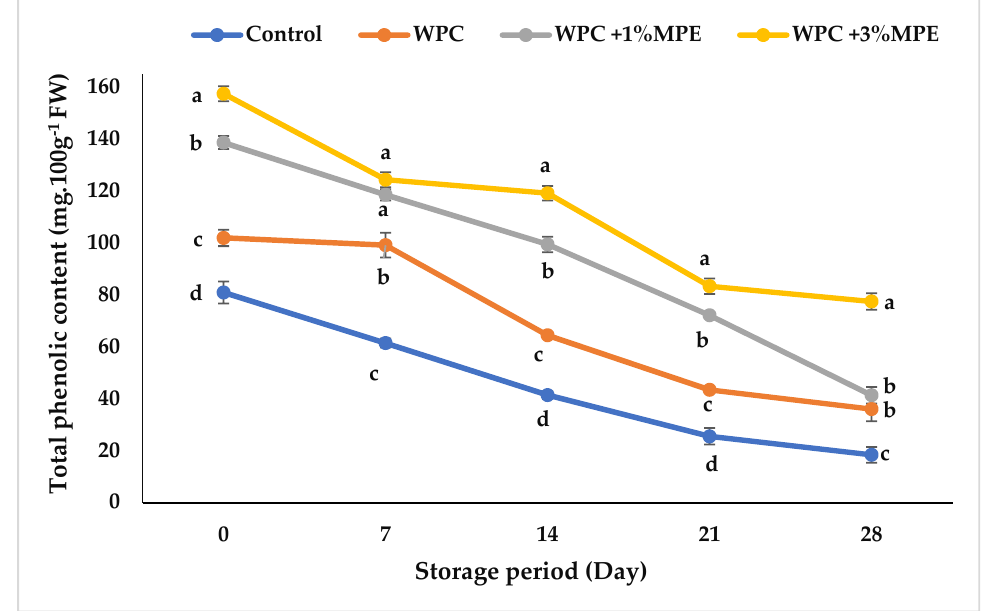
Figure 6. Effect of whey protein concentrate combined with mango peel extract (WPC = whey protein concentrate alone, WPC + 1% MPE = whey protein concentrate + mango peel extract at 1% and WPC + 3% MPE = whey protein concentrate + mango peel extract at 3%) on total phenolic content of broccoli fresh-cuts at 5 °C. Vertical bars indicate standard deviation (n = 6). Means and different letters indicate significant difference between treated and control broccoli for each storage period (Duncan’s multiple range test at 95%).